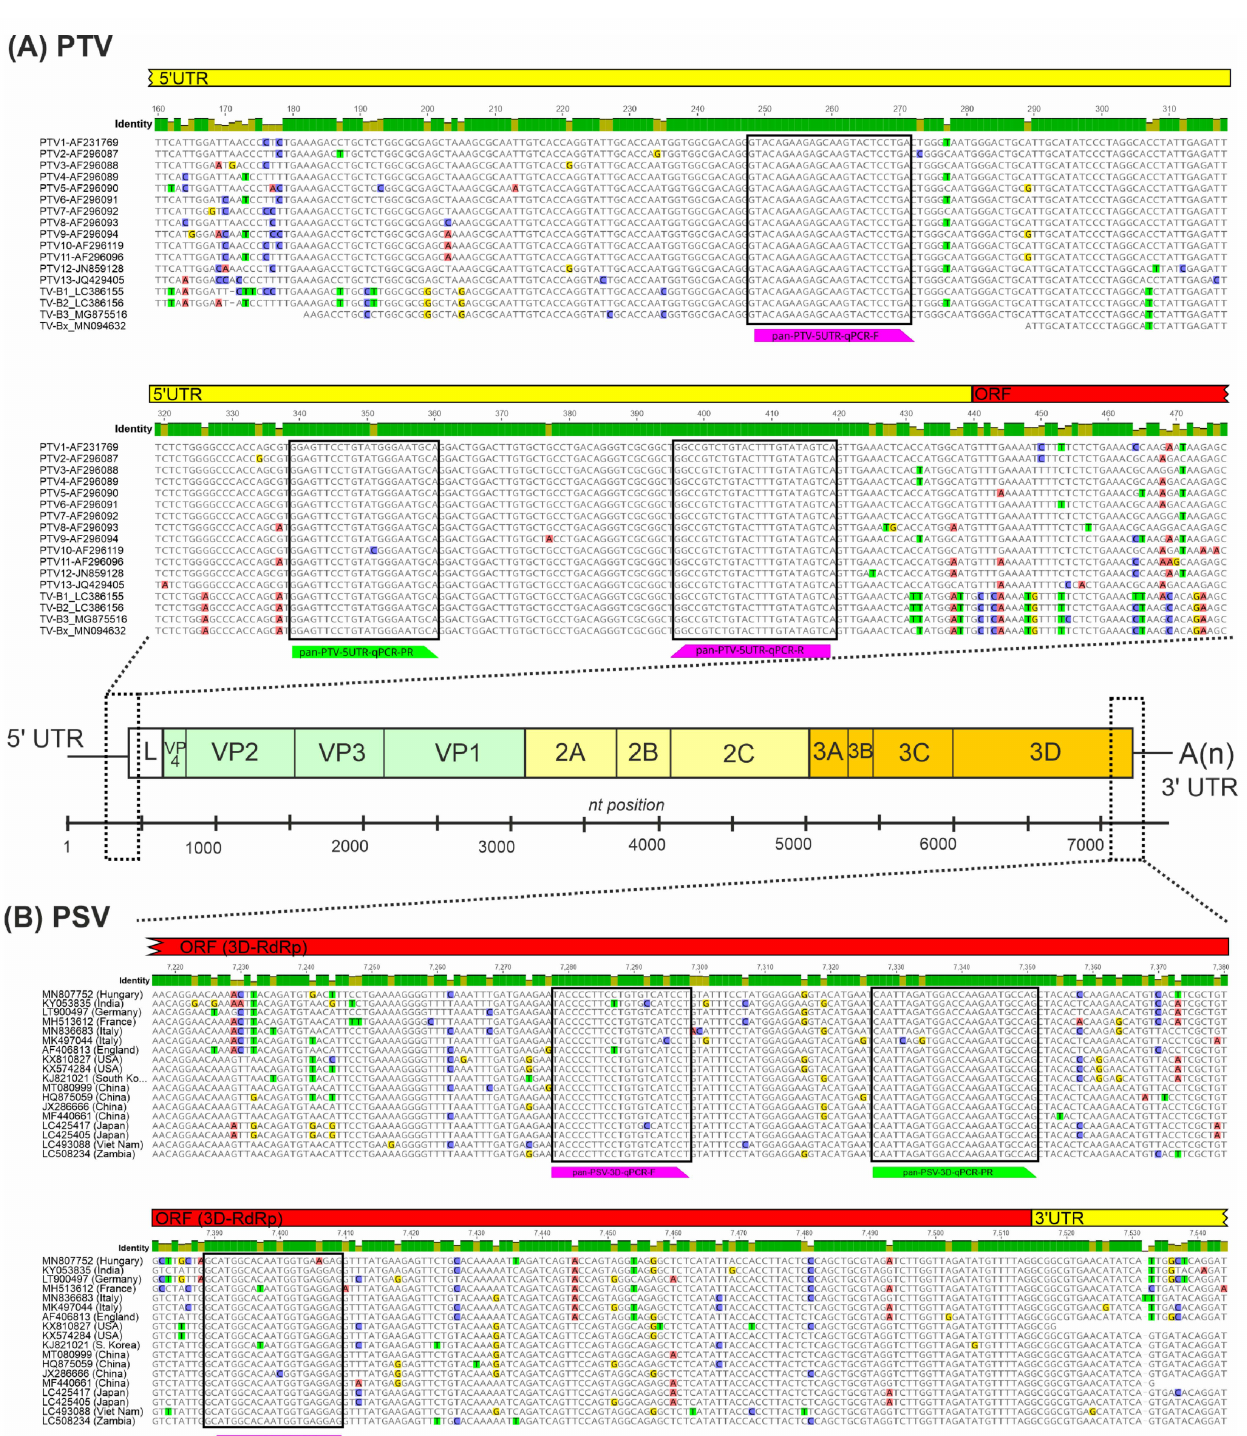
Figure 2. Partial 5 (cid:48) UTR-L and 3D RdRp -3 (cid:48) UTR nucleotide sequence alignments of representative members of Teschovirus A and B ( A ) and Sapelovirus A ( B ) with the binding sites of oligonucleotide primers (magenta) and probes (green) used in singleplex/triplex RT-qPCR assays of this study. The locations of the aligned regions and primer–probe binding sites are marked with dotted lines in a schematic picornavirus genome map. The identity graphs above the alignments show the identical (green bars) and moderately variable (pale yellow bars) genomic regions. The countries of origins of different Sapelovirus A sequences are found in brackets after the accession